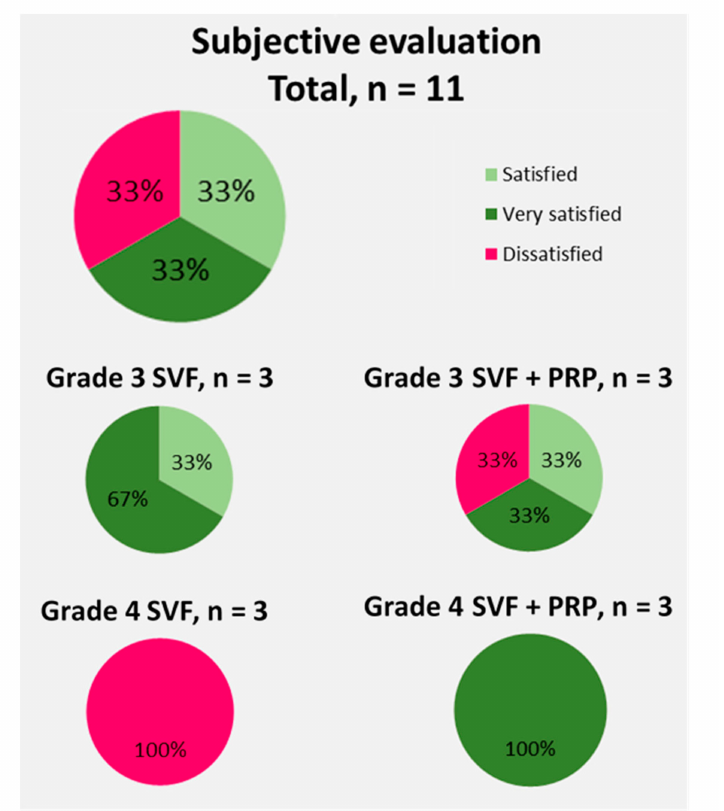
Figure 6. Subjective evaluation of the 11 patients on their overall satisfaction with the SVF treatment of their knee osteoarthritis with freshly isolated SVF from the adipose tissue.